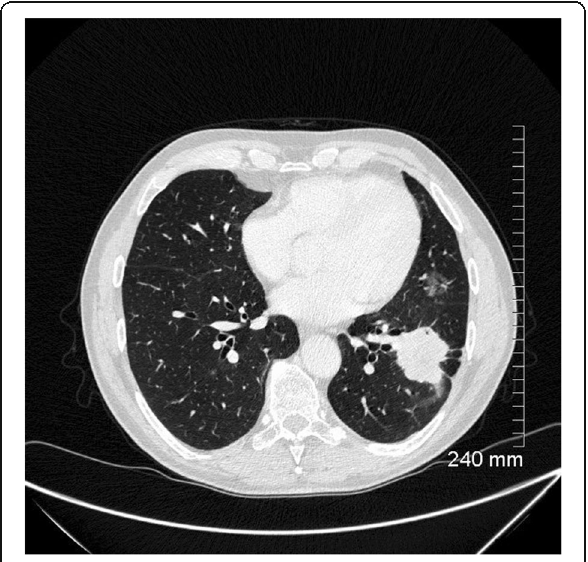
Fig. 14 Unfavourable prognostic indicators: thickened bronchovascular bundle. The 4-cm solid mass in the left lower lobe also demonstrates spiculated margins and pleural tethering with small foci of internal cavitation. A smaller ground glass nodule in the lingula was found to represent a synchronous AIS after surgical